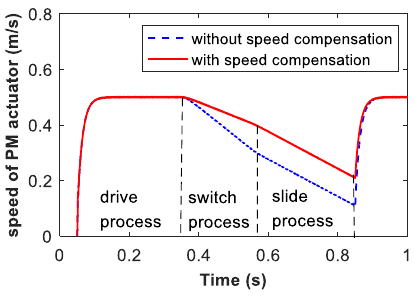
Figure 9. Speed curves of segmented PMLSM during switch process. Table 2. Simulation performances of segmented PMLSM with proportional-integral-derivative (PID) and improved SMC model.